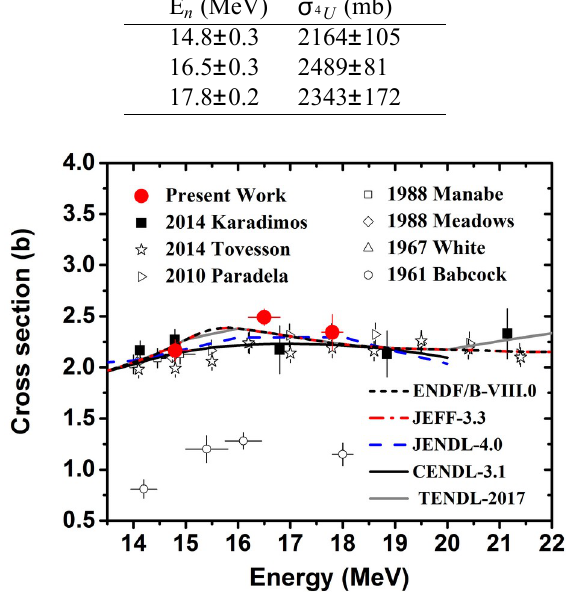
Figure 6. Experimental cross section values of the present work, along with previously existing data points in literature [22] and the ENDF / B-VIII.0, JEFF-3.3, JENDL-4.0, CENDL-3.1 and TENDL-2017 evaluation libraries [16] for the 234 U(n,f) reaction, in the energy region of